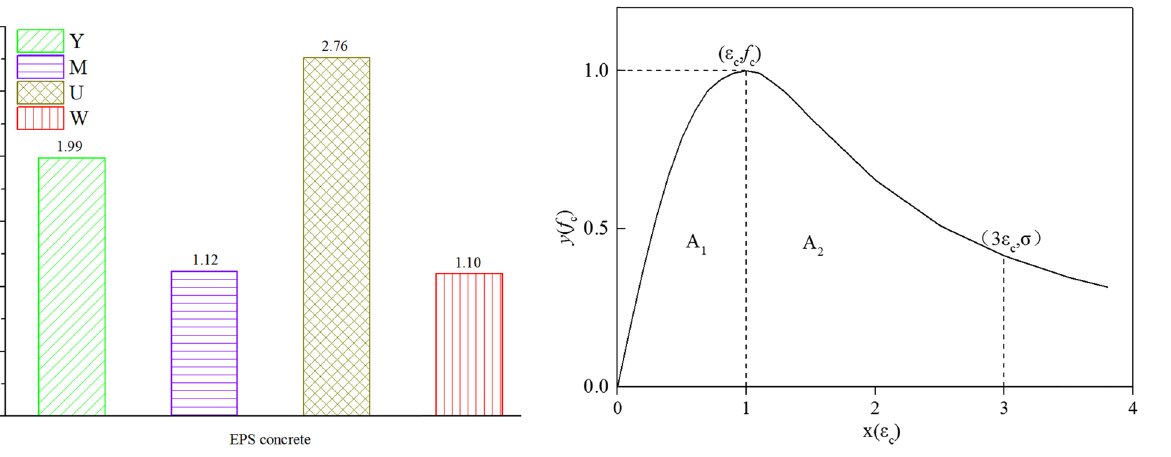
Figure 15: Ductility coe ffi cient of EPS concrete. Figure 16: Characteristic points of toughness and brittleness